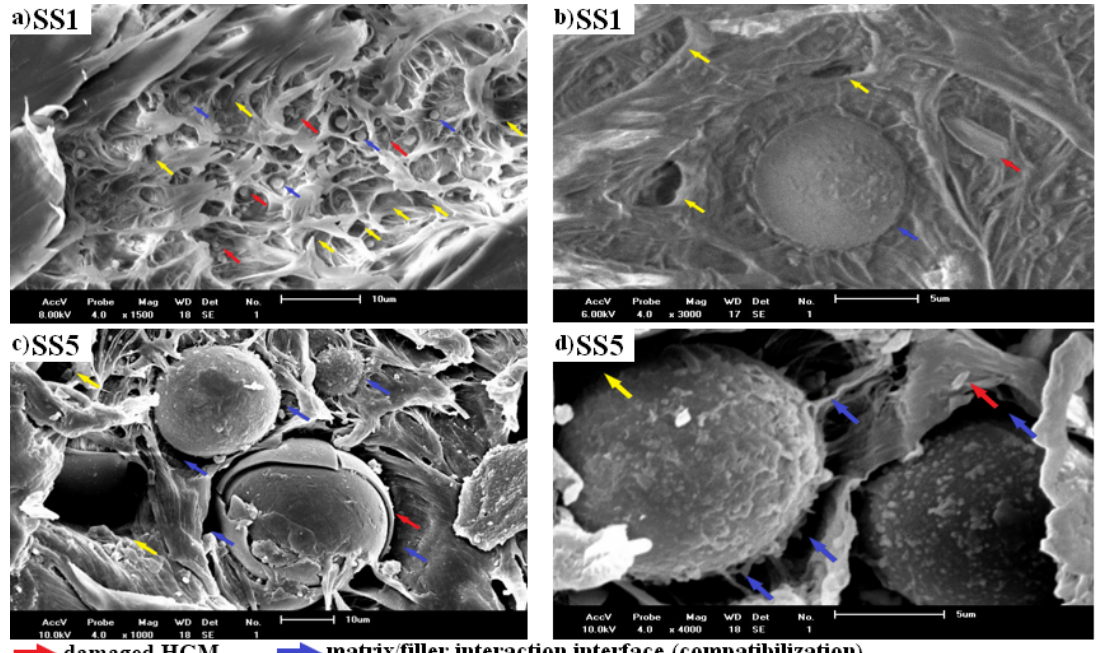
Figure 2. Photomicrographs of single screw extruded systems (SS) with 1 (SS1) and 5% (SS5) HGM.